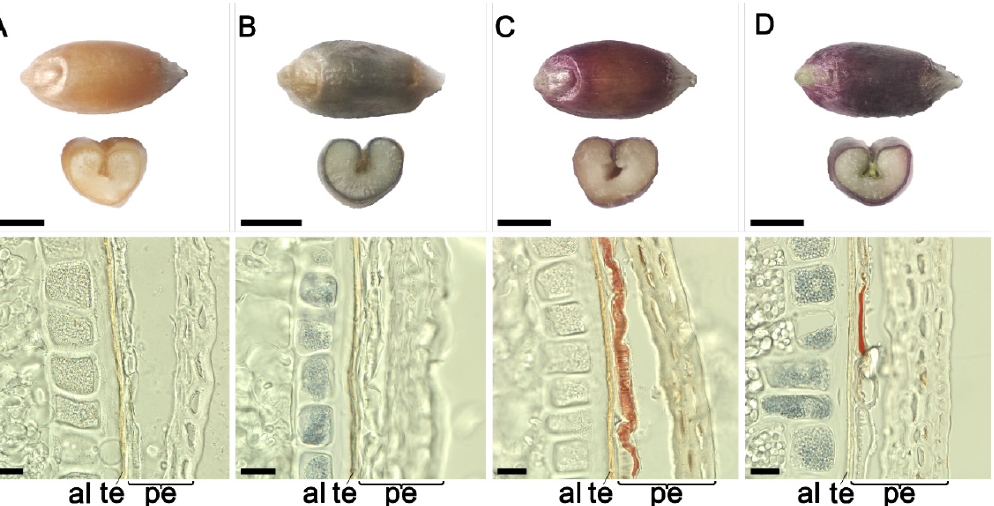
Figure 3. The seeds and cross ‐ sections of the seeds produced by cv . S29 ( A ) and lines i:S29 Pp3 P Pp ‐ D1 PF ( B ), s:S29 Ba1 4Th(4D) ( C ), and s:S29 Ba1 4Th(4D) Pp3 P Pp ‐ D1 PF ( D ) sampled at the ( B ), i:S29 Pp3 P Pp-D1 PF ( C ), and s:S29 Ba1 4Th(4D) Pp3 P Pp-D1 PF ( D ) sampled at the hard-dough stage. al: aleurone layer, te: testa, pe: pericarp. The scale bars for the seeds are 2.5 mm, and for the micrographs, 25 µ